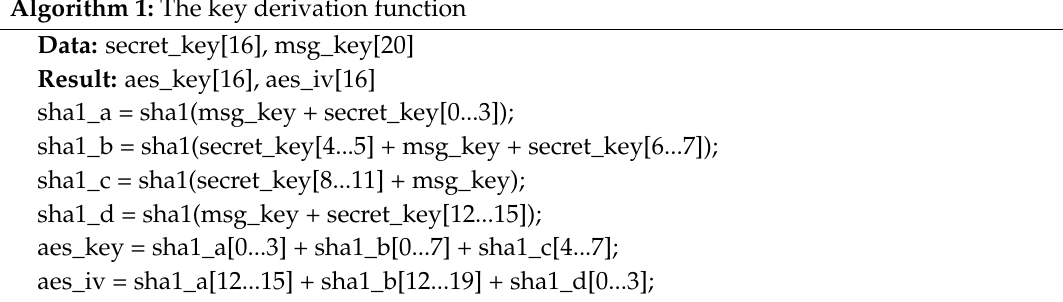
Algorithm 1: The key derivation